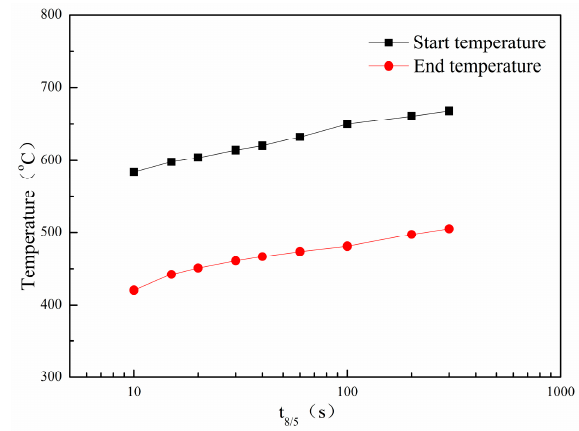
Figure 4. Effect of t 8/5 on the onset and end temperatures for continuous cooling transformation occurring in the simulated CGHAZ.